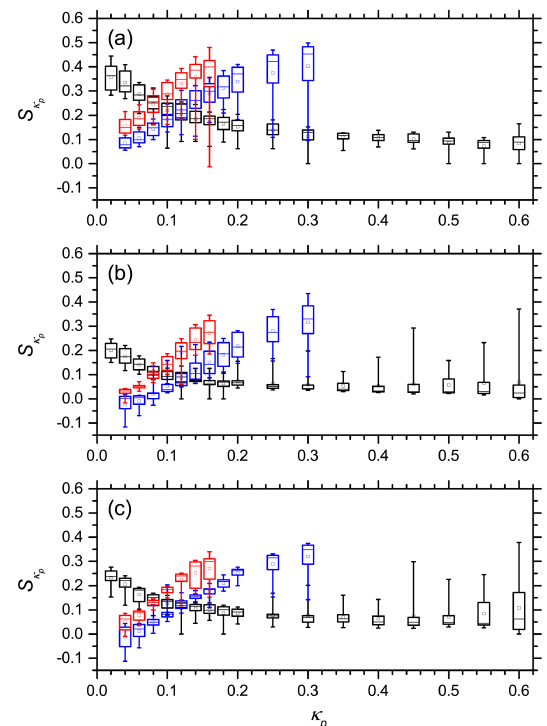
Figure 6. Box-and-whisker plots of the sensitivity S κ hygroscopicity parameter κ p , showing spread of results for updraft velocities between 0.1 and 10ms − 1 , for (a) MP 5 , 1 , (b) MP 1 , 5 and (c) HP 5 , 5 case studies. Box bounds show the interquartile range, the mean value is indicated by a small square, and whiskers delimitate minimum and maximum values. Results for the internally mixed Int and externally mixed populations Ext 1 and Ext 2 are plotted in black, red and blue,